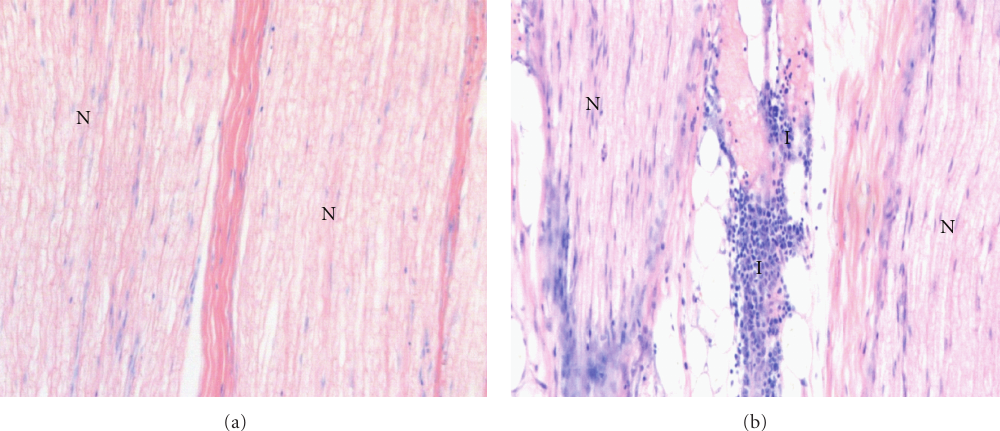
Figure 3: (a) Longitudinal microscopic view ( × 200, Giemsa stained) of the radial nerve after needle placement by means of nerve stimulation. A minimal threshold current of 1.0mA was applied for needle positioning. The needle did not contact the nerve tissue. N, nerve fascicle; I, inflammatory cells. Score value, 0 (b) Longitudinal microscopic view ( × 200, Giemsa stained) of the median nerve after needle placement by means of nerve stimulation. A minimal threshold current of 0.2mA was applied for needle positioning. The needle contacted the nerve tissue. N, nerve fascicle; I, inflammatory cells. Score value, 2.0.